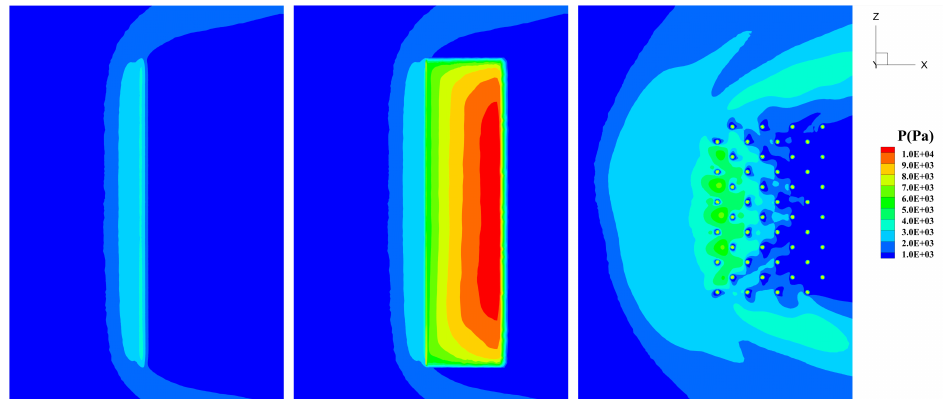
Figure 9. Surface Pressure Contour around the Control Surfaces in Case 2 and Case 4. ( Left : Body Flap hidden; Middle : Body Flap shown; Right : AJM.)